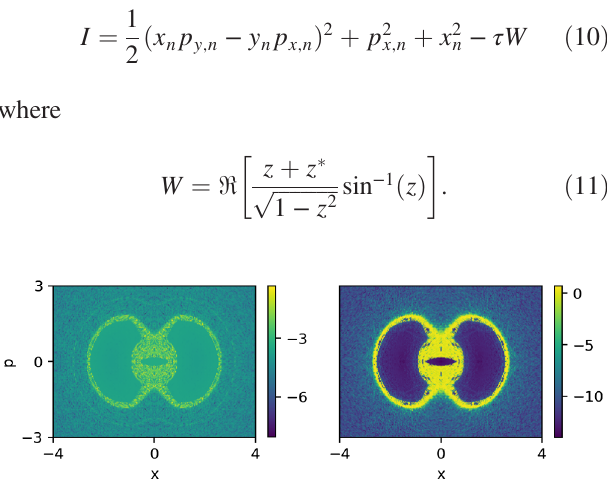
FIG. 12. Dynamic aperture plot using FMA and REM for the tune depression ratio η ¼ 0 . 1 and mismatch X ð 0 Þ ¼ 0 . 577 with the sampling period slight larger than the stroboscopic period (by